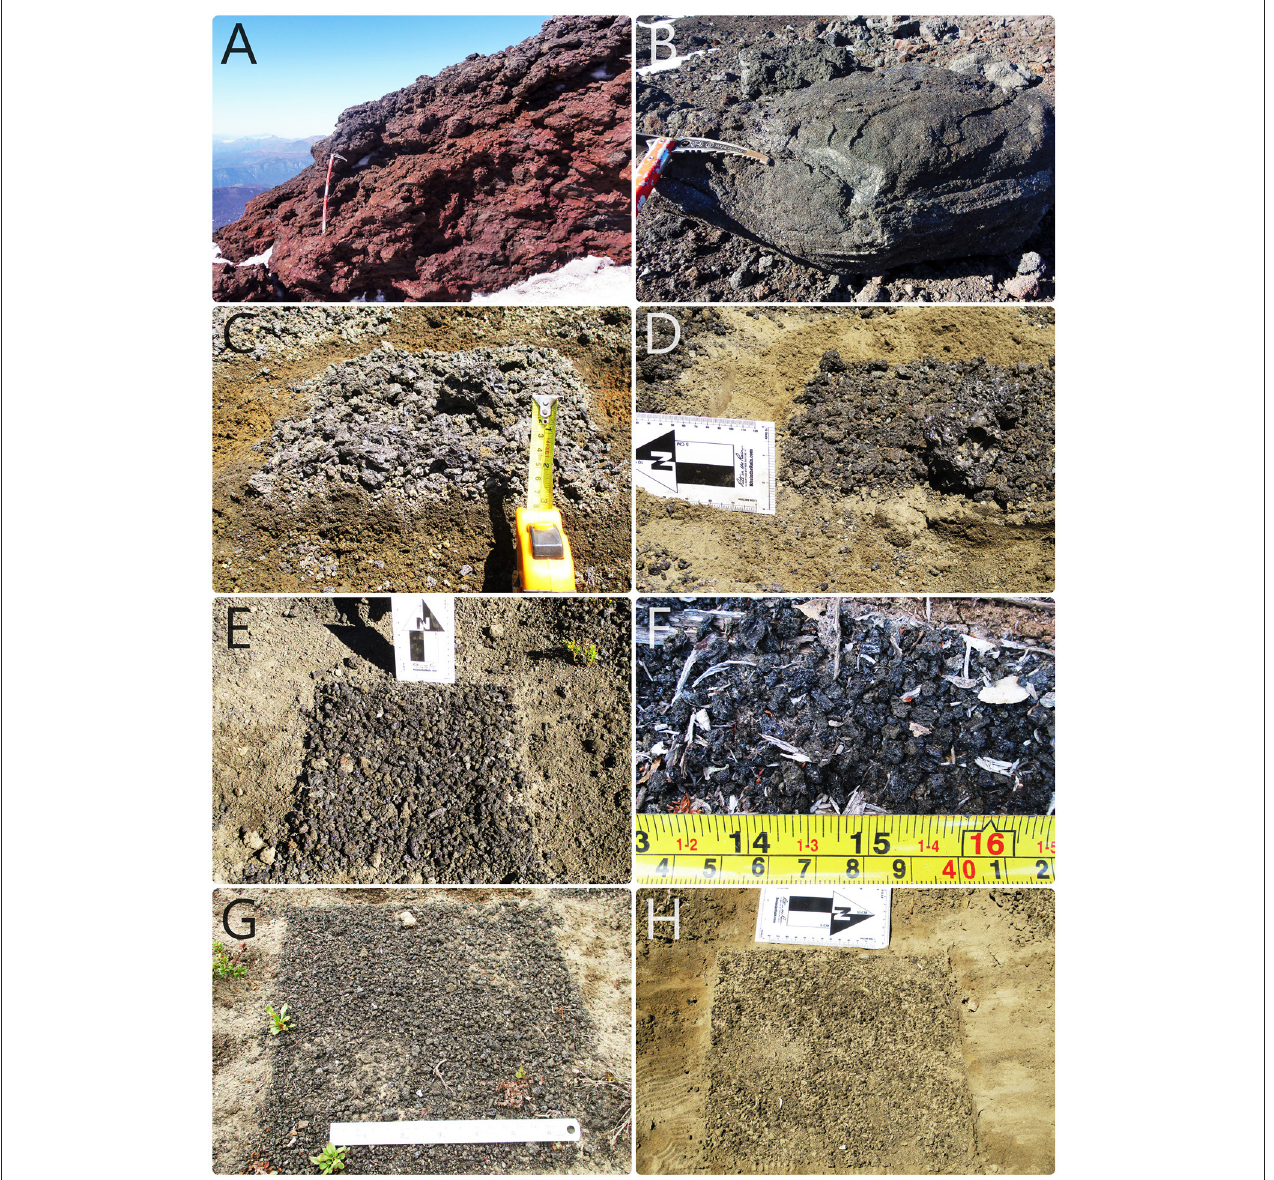
FIGURE 4 | Field features of the tephra fall deposit. (A) Non-welded agglutination of spatters close to the summit of Villarrica (photo by Franco Vera). Ax pick is 66cm long. (B) Metric-sized fusiform bomb in the upper flanks of the volcano (photo by Franco Vera). (C , D) Proximal, reverse graded tephra fall deposit at 6 and 7km distance east-northeast from the vent, respectively. Decimetre-sized scoria bombs are found on top. (E) Medial deposit found 8km southeast the vent. Note that the clast size is smaller (medium to coarse lapilli) than at proximal distances, and bombs are relatively scarce on top. (F) Medial deposit 13km east-northeast from the vent, exclusively consisting of medium-sized scoria lapilli. (G , H) Distal deposits with fine to medium sized scoria lapilli at 21 and 43km distance, east-southeast from the vent. Scale length in G is 16.5cm. Pictures (B–H) by Jorge Romero and Franco Vera.